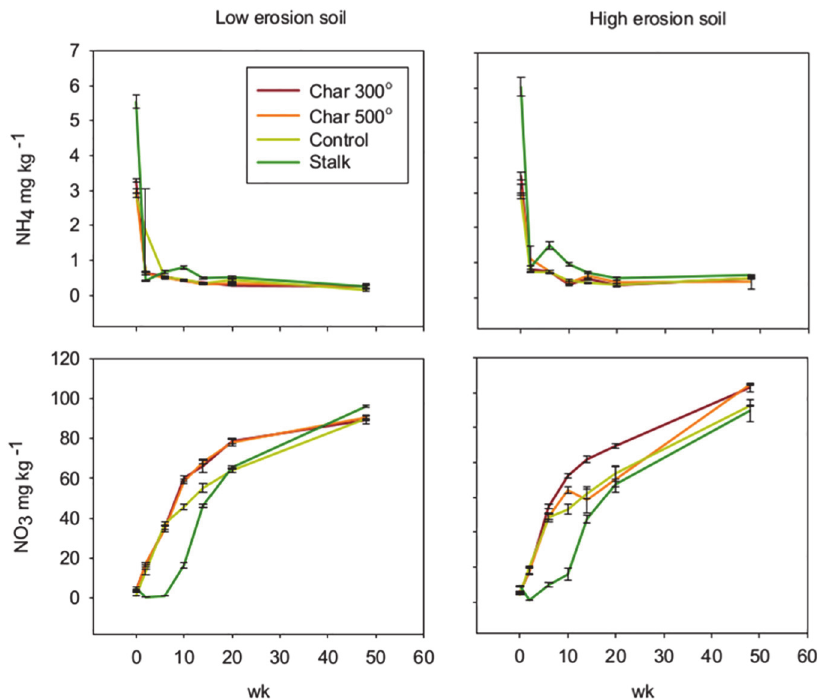
Fig 2. Mineral N dynamics during the incubation of the low-erosion (right graphs) and high-erosion soils (left graphs). Ammonium data is in the top graphs, and nitrate data is in the bottom graphs. Error bars are the SEM.